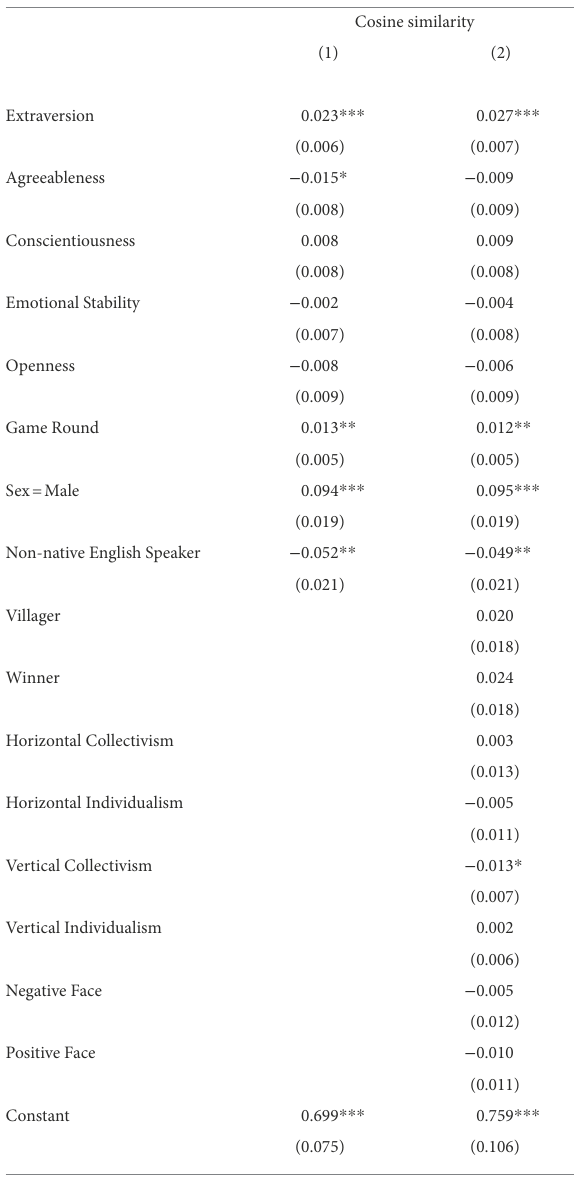
TABLE 7 Effect of personality on style